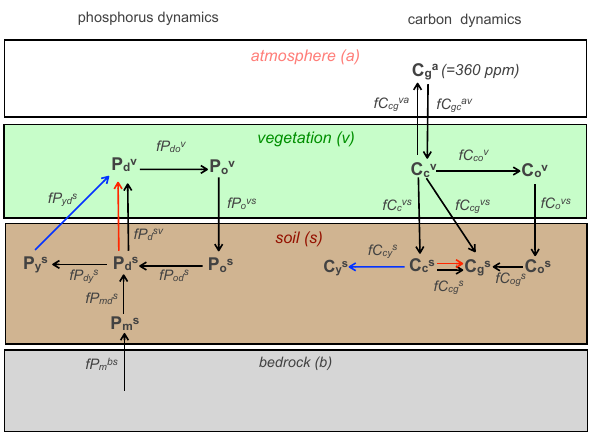
Figure 4. The C–P biogeochemical model: symbols in bold denote pools and symbols, in italic denote fluxes between pools. Black ar- rows show fluxes in the standard version of the model (W-P); blue arrows show P de-occlusion and the associated carbon flux to re- calcitrant forms (BD); red arrows show P active uptake mediated by mycorrhizae and its associated carbon respiration (BAU). The model has a switch for turning on and off active P uptake (blue fluxes) and biotic de-occlusion of P (red fluxes). For definition of symbols see Table A3.